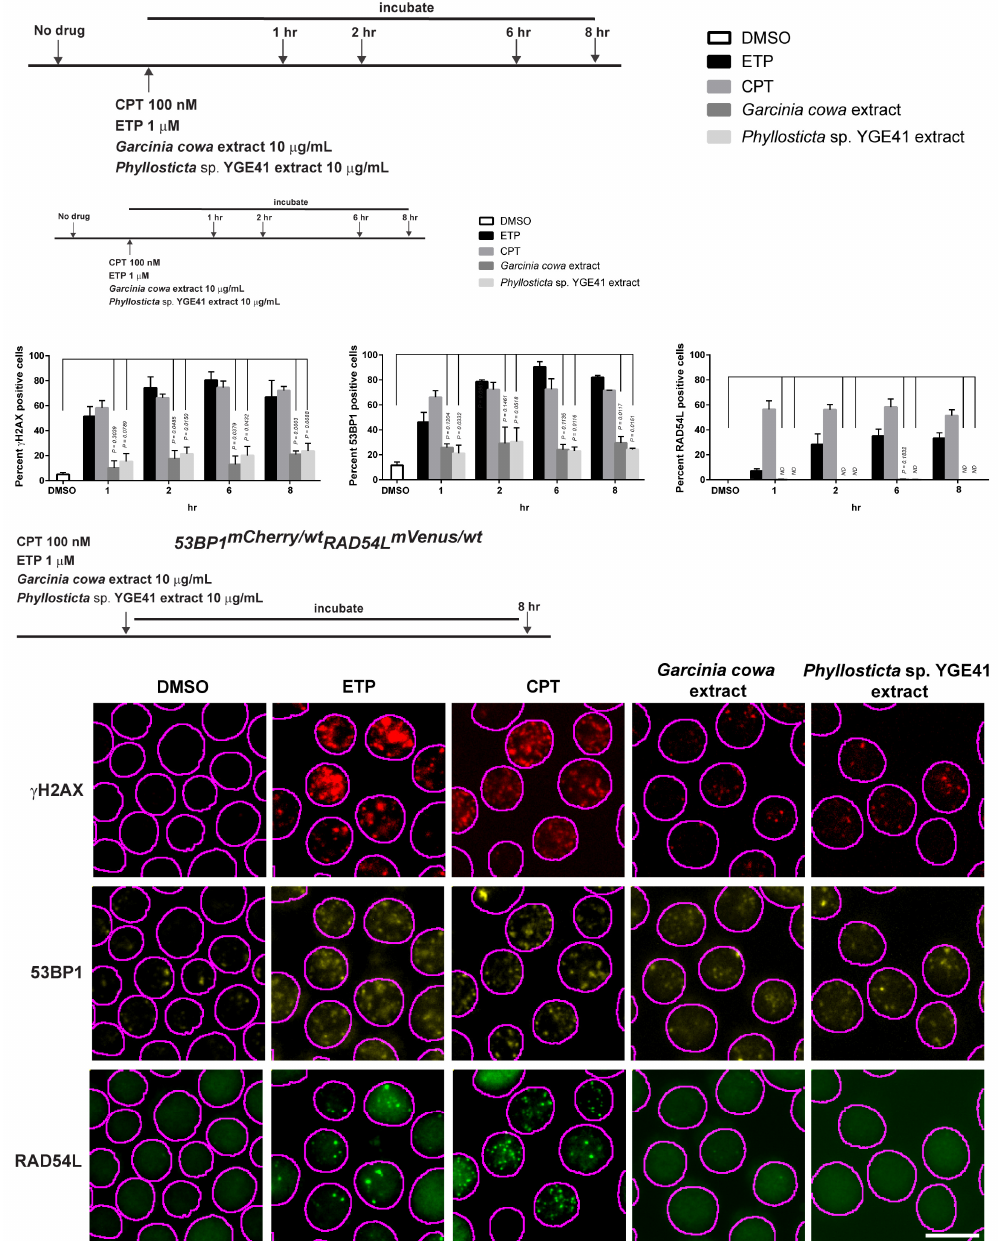
Figure 8. Garcinia cowa and Phyllosticta sp. YGE41 crude extracts caused mild DSB and activated NHEJ. The biosensor cells were continuously treated with the crude extracts for 8 h and were collected at the indicated time. The bar graphs are shown as the mean ± standard deviation. The foci formation images are represented at 8 h. Definitions: DMSO, dimethyl sulfoxide; ETP, etoposide; CPT, camptothecin; ND, Student’s t -test cannot be